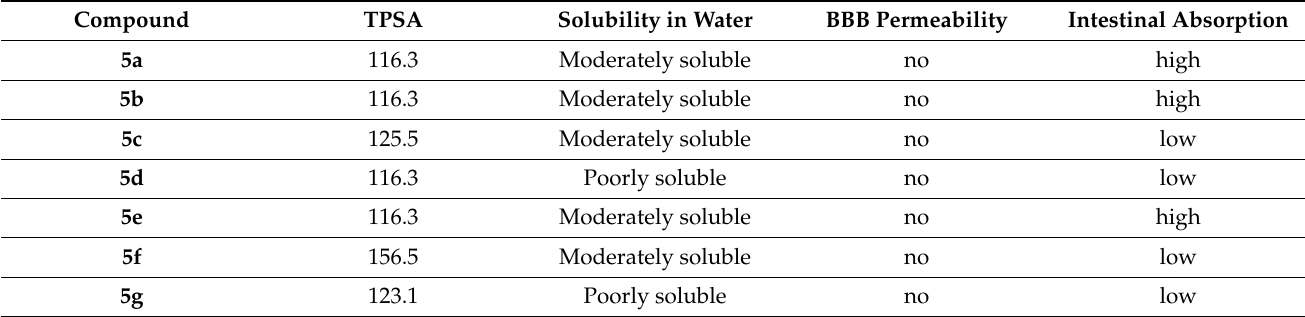
Table 6. Predicted pharmacokinetic properties of compounds 5a–5g